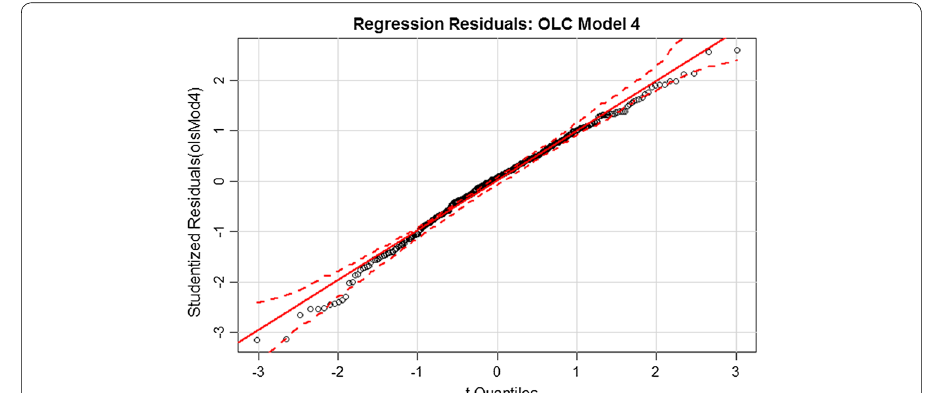
Fig. 1 Model regression with studentized